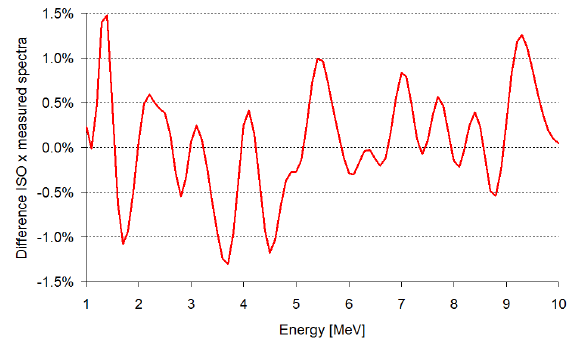
Figure 2. Comparison between leakage spectra calculated with ISO AmBe spectra and measured spectra.